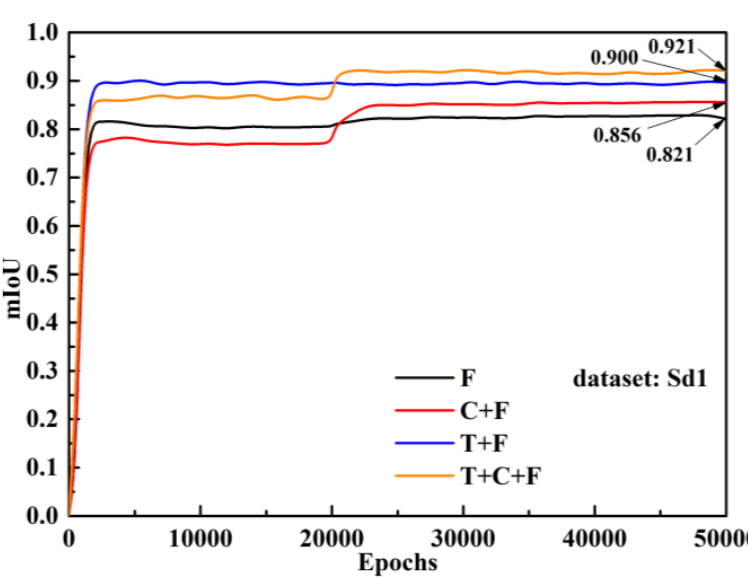
Figure 8. mIoU curves of four training types .